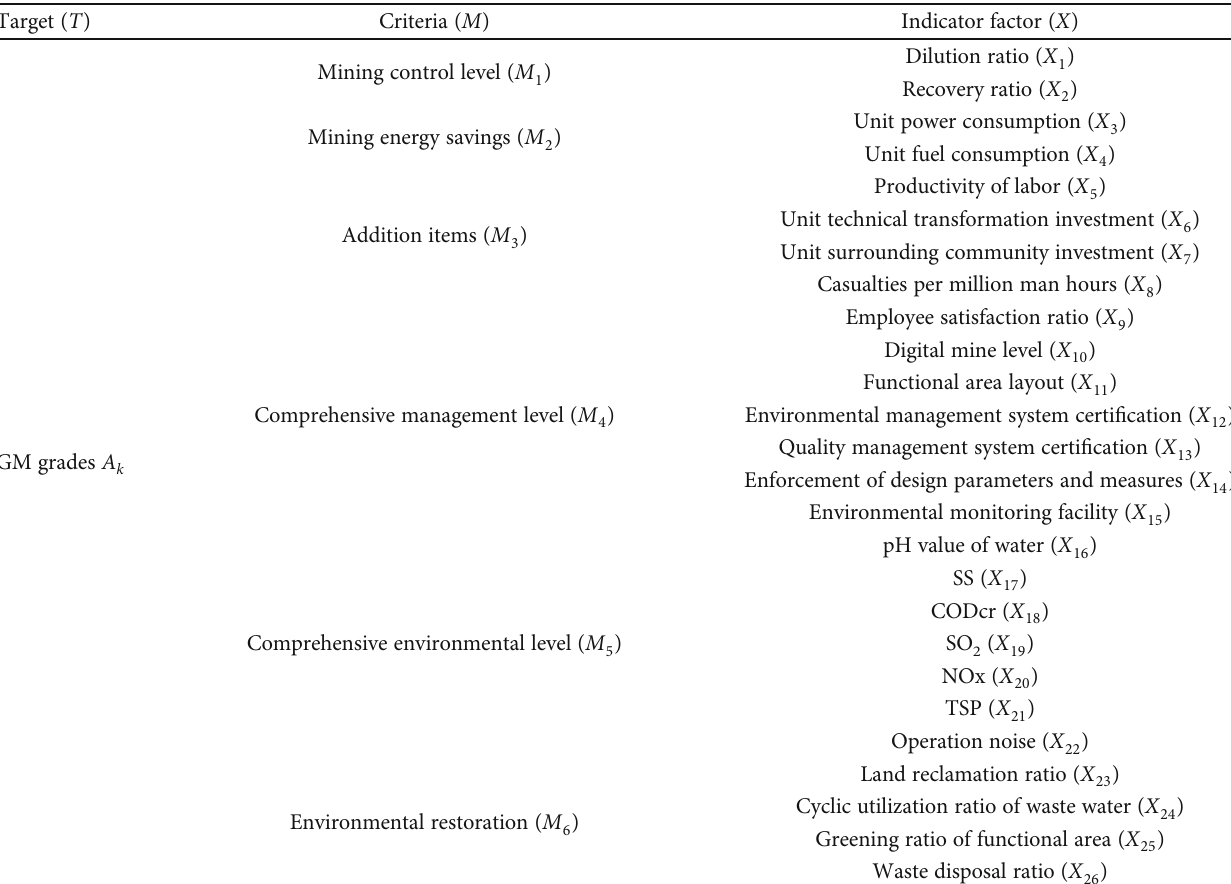
Table 2: AHP model for GM grades of